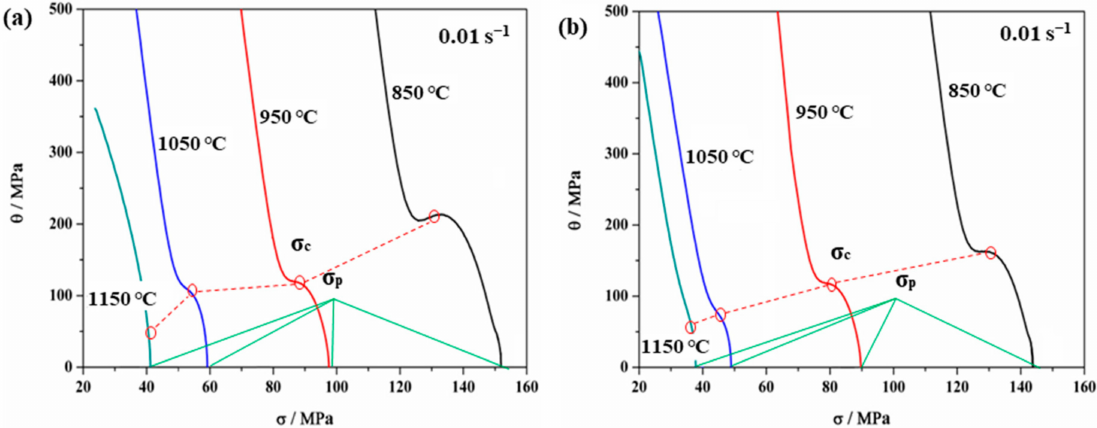
Figure 6. Relationship between θ and σ of 35CrMo steel under 0.01 s − 1 : ( a ) without ultrasonic, ( b ) with ultrasonic.